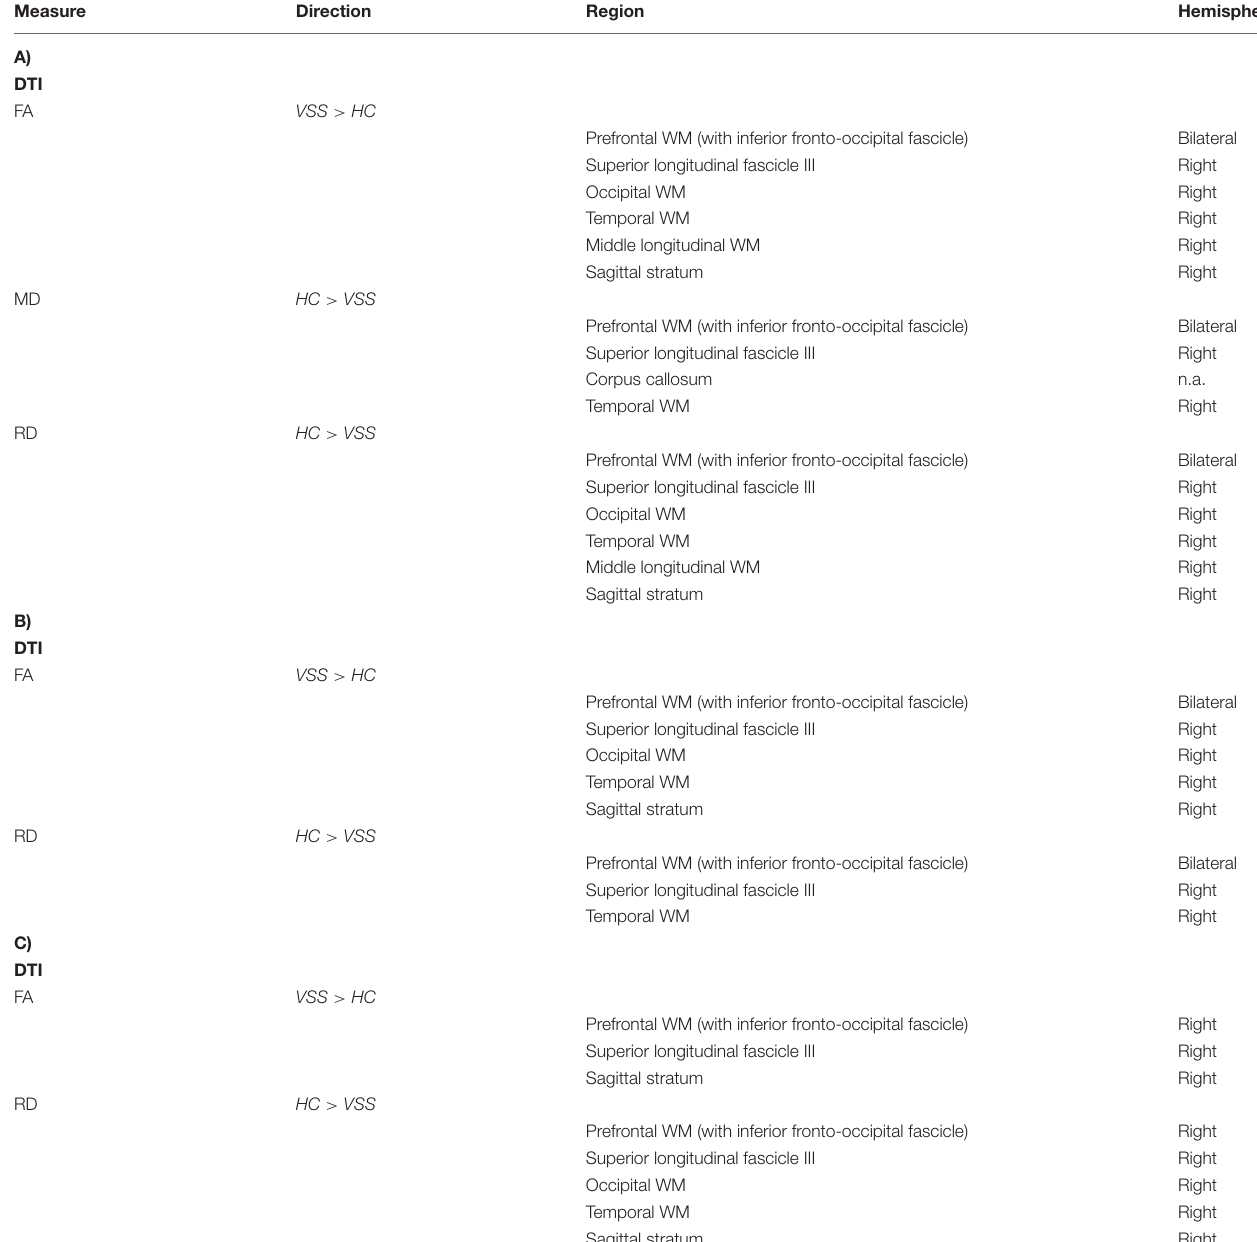
TABLE 2 | Summary of DTI group